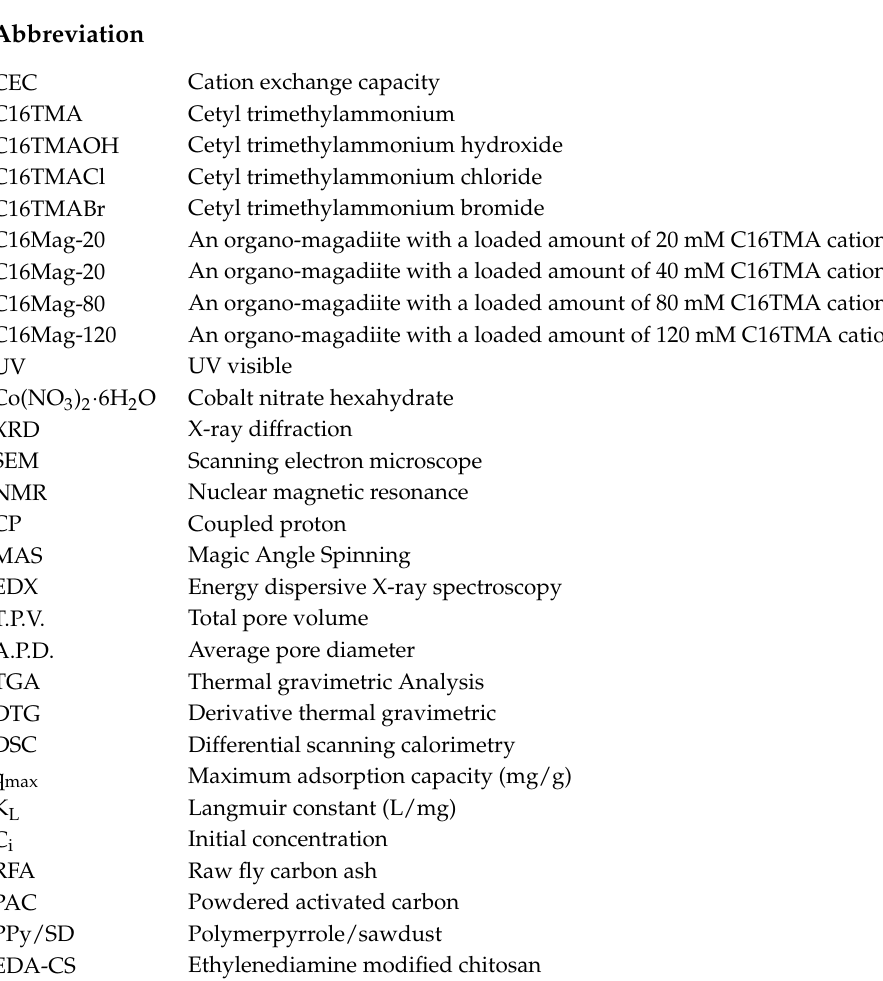
Figure S4: in-situ powder XRD patterns of (a) Na-magadiite treated at different temperatures, (b) 50 ◦ C, (c) 100 ◦ C, (d) 150 ◦ C, (e) 200 ◦ C, (f) 250 ◦ C and (g) 400 ◦ C, Figure S5: Removal properties of C16Mag-80 for eosin